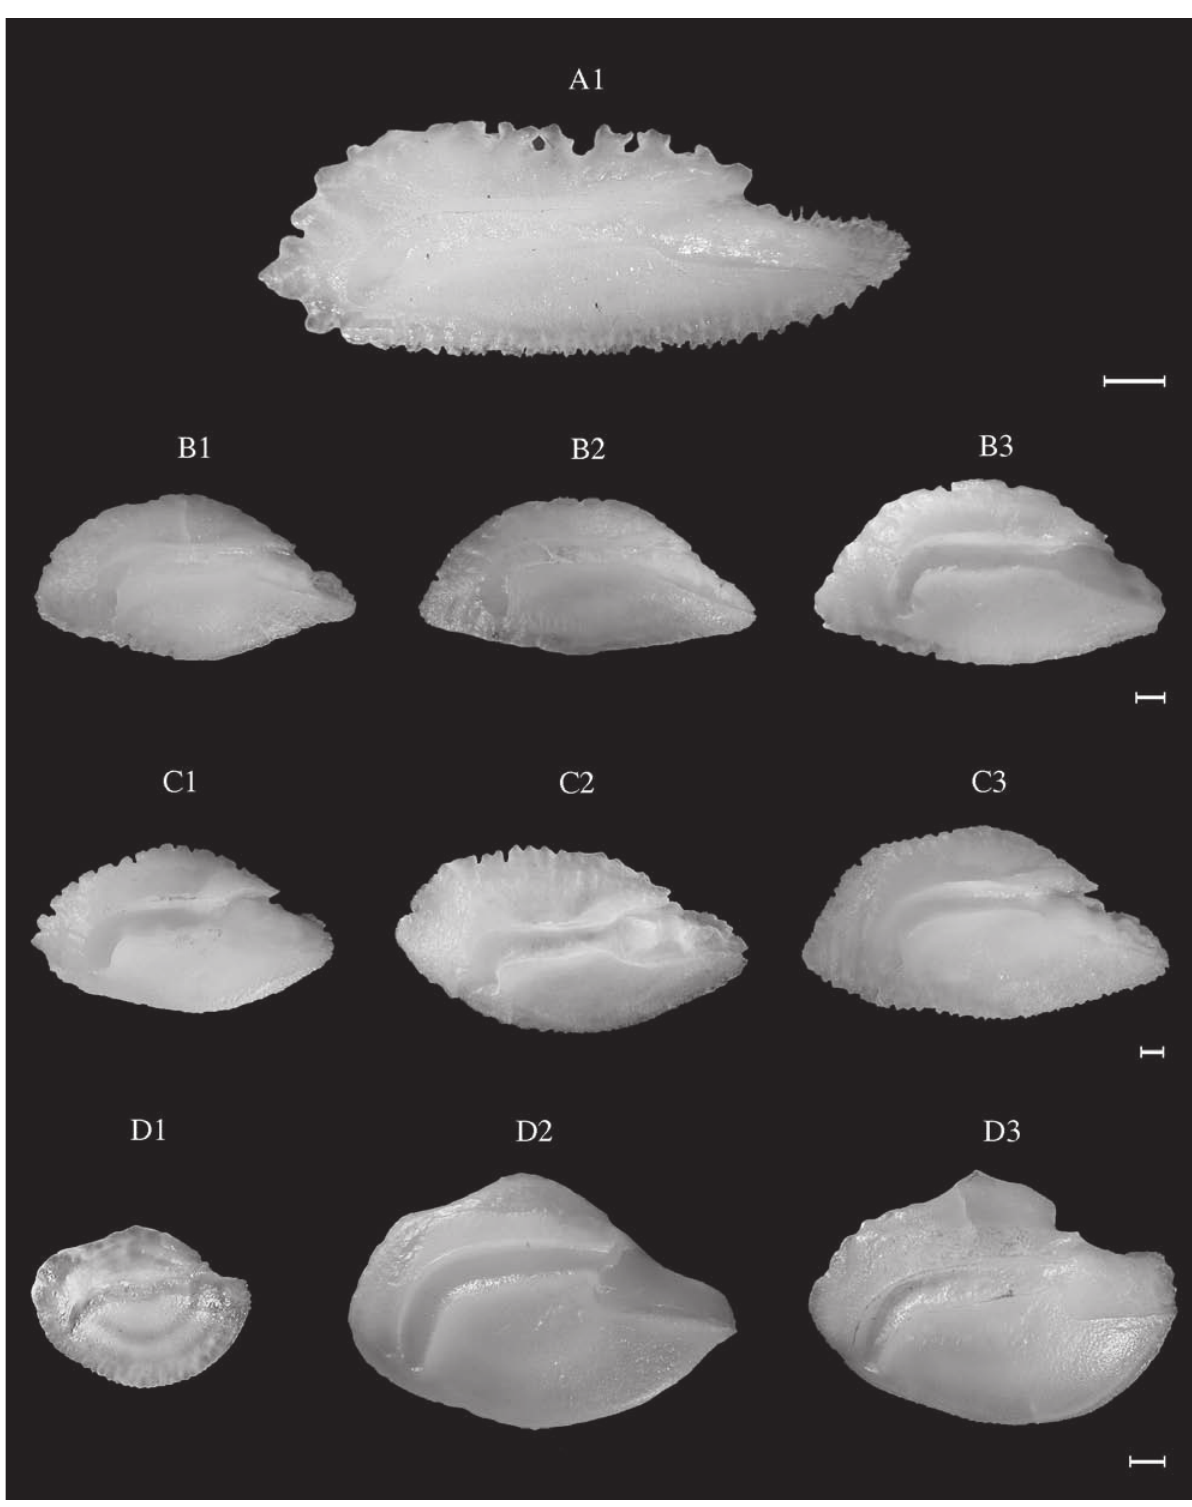
Fig. 55. – Erythrocles monodi (CEA). TL: A1, 41.2 cm. Parapristipoma octolineatum (CEA). TL: B1, 30.7 cm; B2, 32.5 cm; B3, 39.9 cm. Plectorinchus mediterraneus . TL: C1, 34.0 cm (CEA); C2, 38.0 cm (NEA); C3, 38.5 cm (CEA). Pomadasys incisus . TL: D1, 14.0 cm (WM); D2, 21.6 cm (CEA); D3, 24.8 cm (CEA). Scale bar = 1